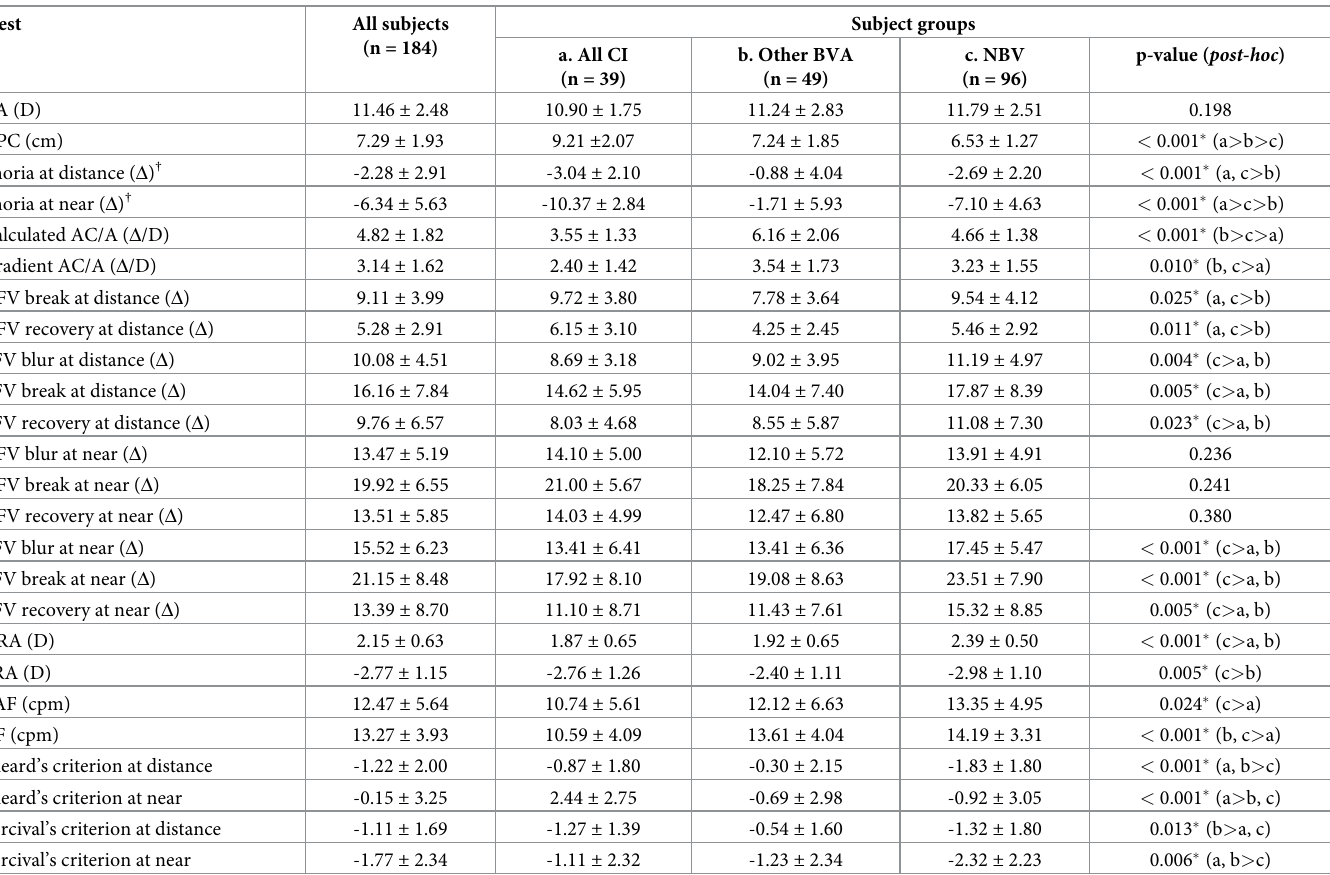
Table 2. Comparison of mean and standard deviation values for the measures of binocular